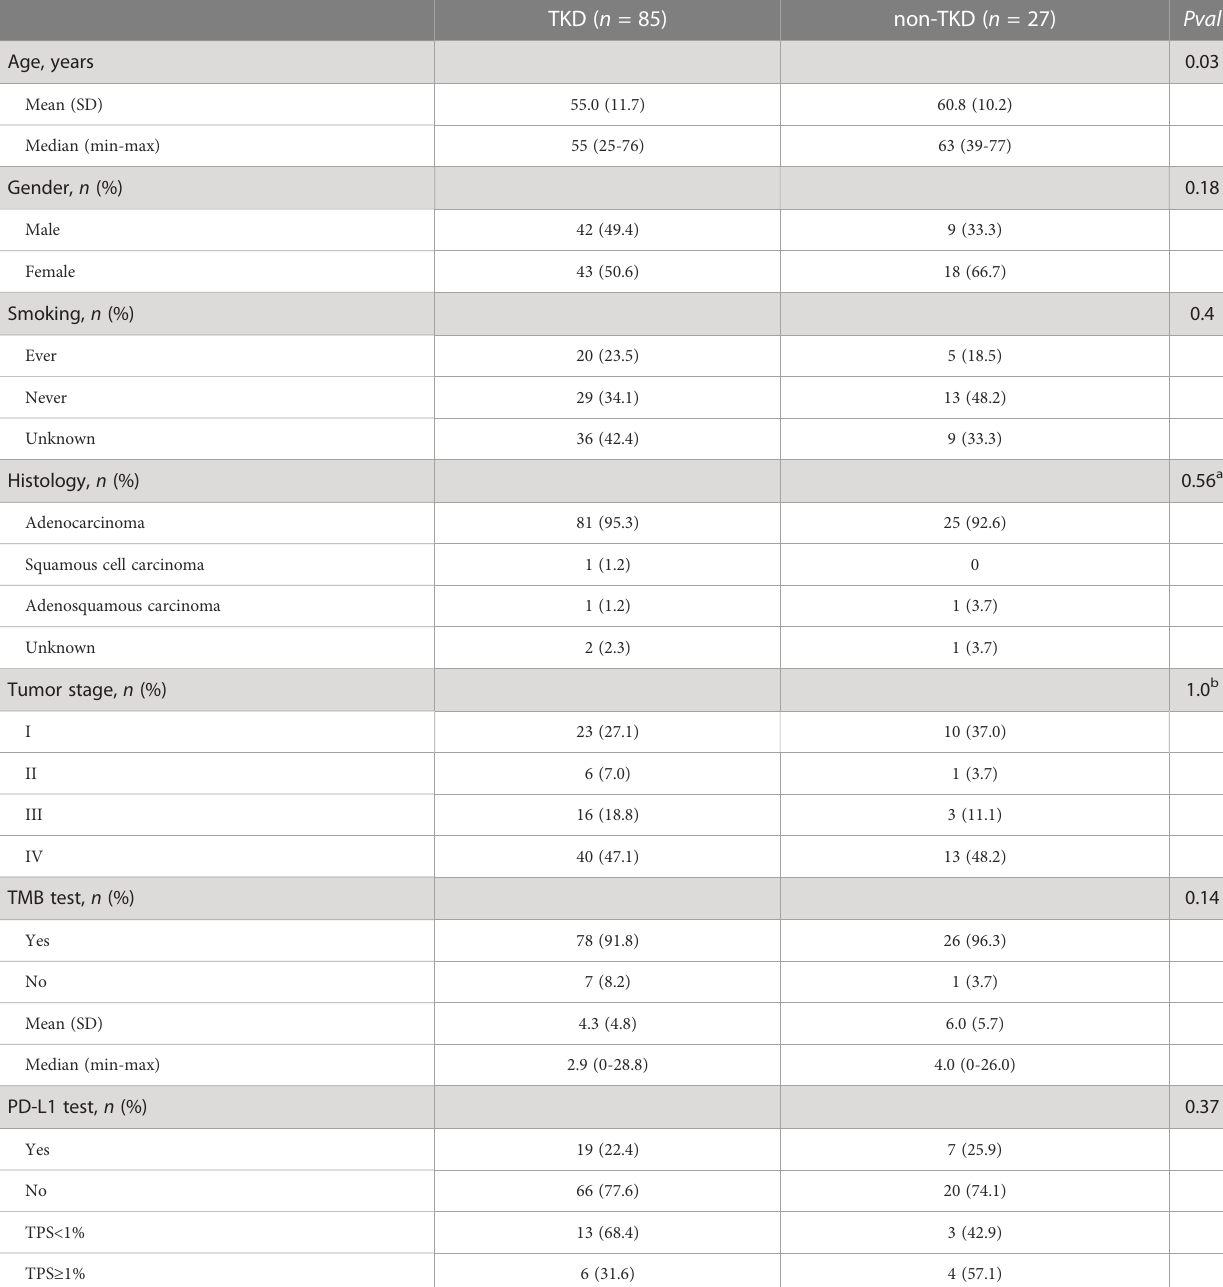
TABLE 2 Baseline clinical and molecular characteristics between treatment-naïve patients with HER2 oncogenic TKD and non-TKD